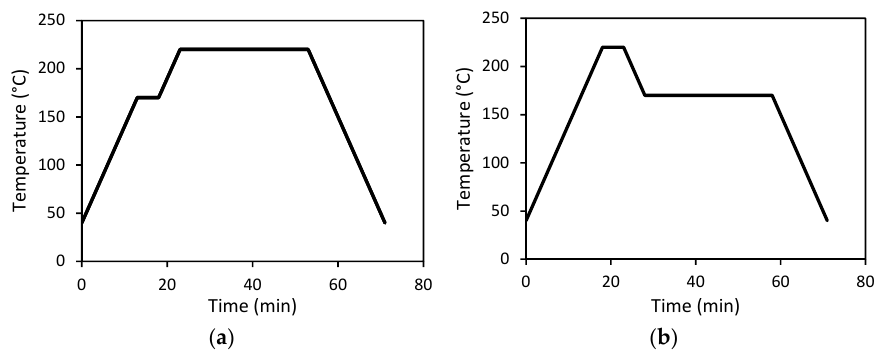
Figure 1. Illustration of ( a ) the conventional compression moulding process and ( b ) the modified compression moulding process.